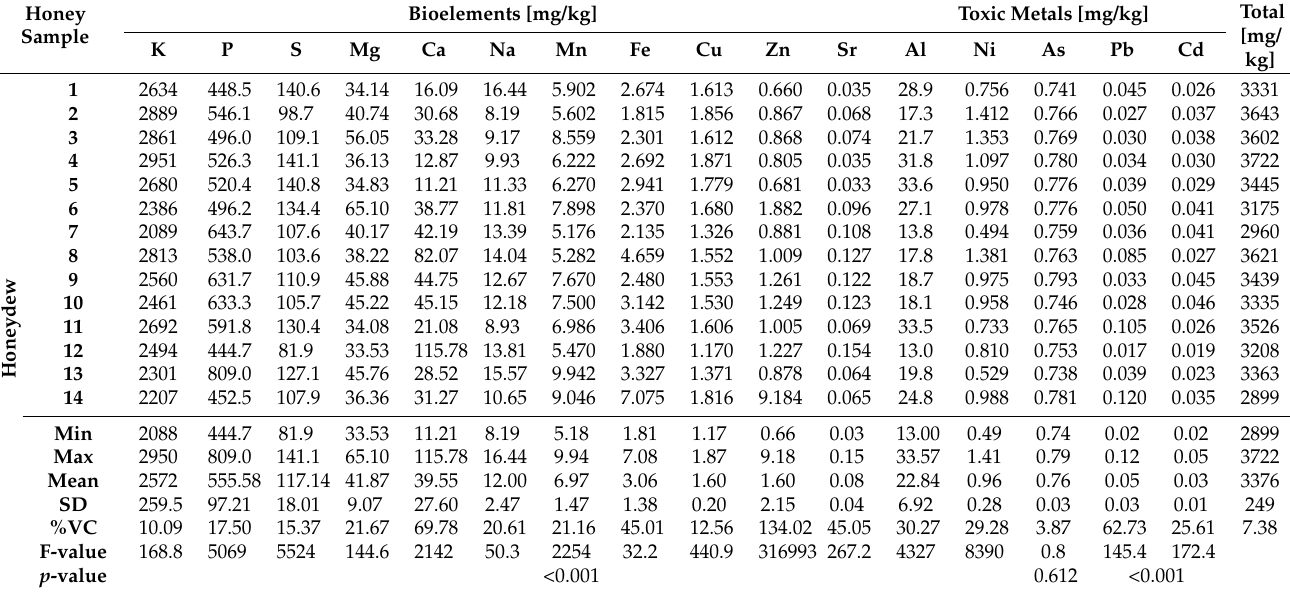
Table 2. Mineral content of honeydew and nectar honeys determined by the ICP-OES method. Mean values (mg/kg) of 3 independent replications are